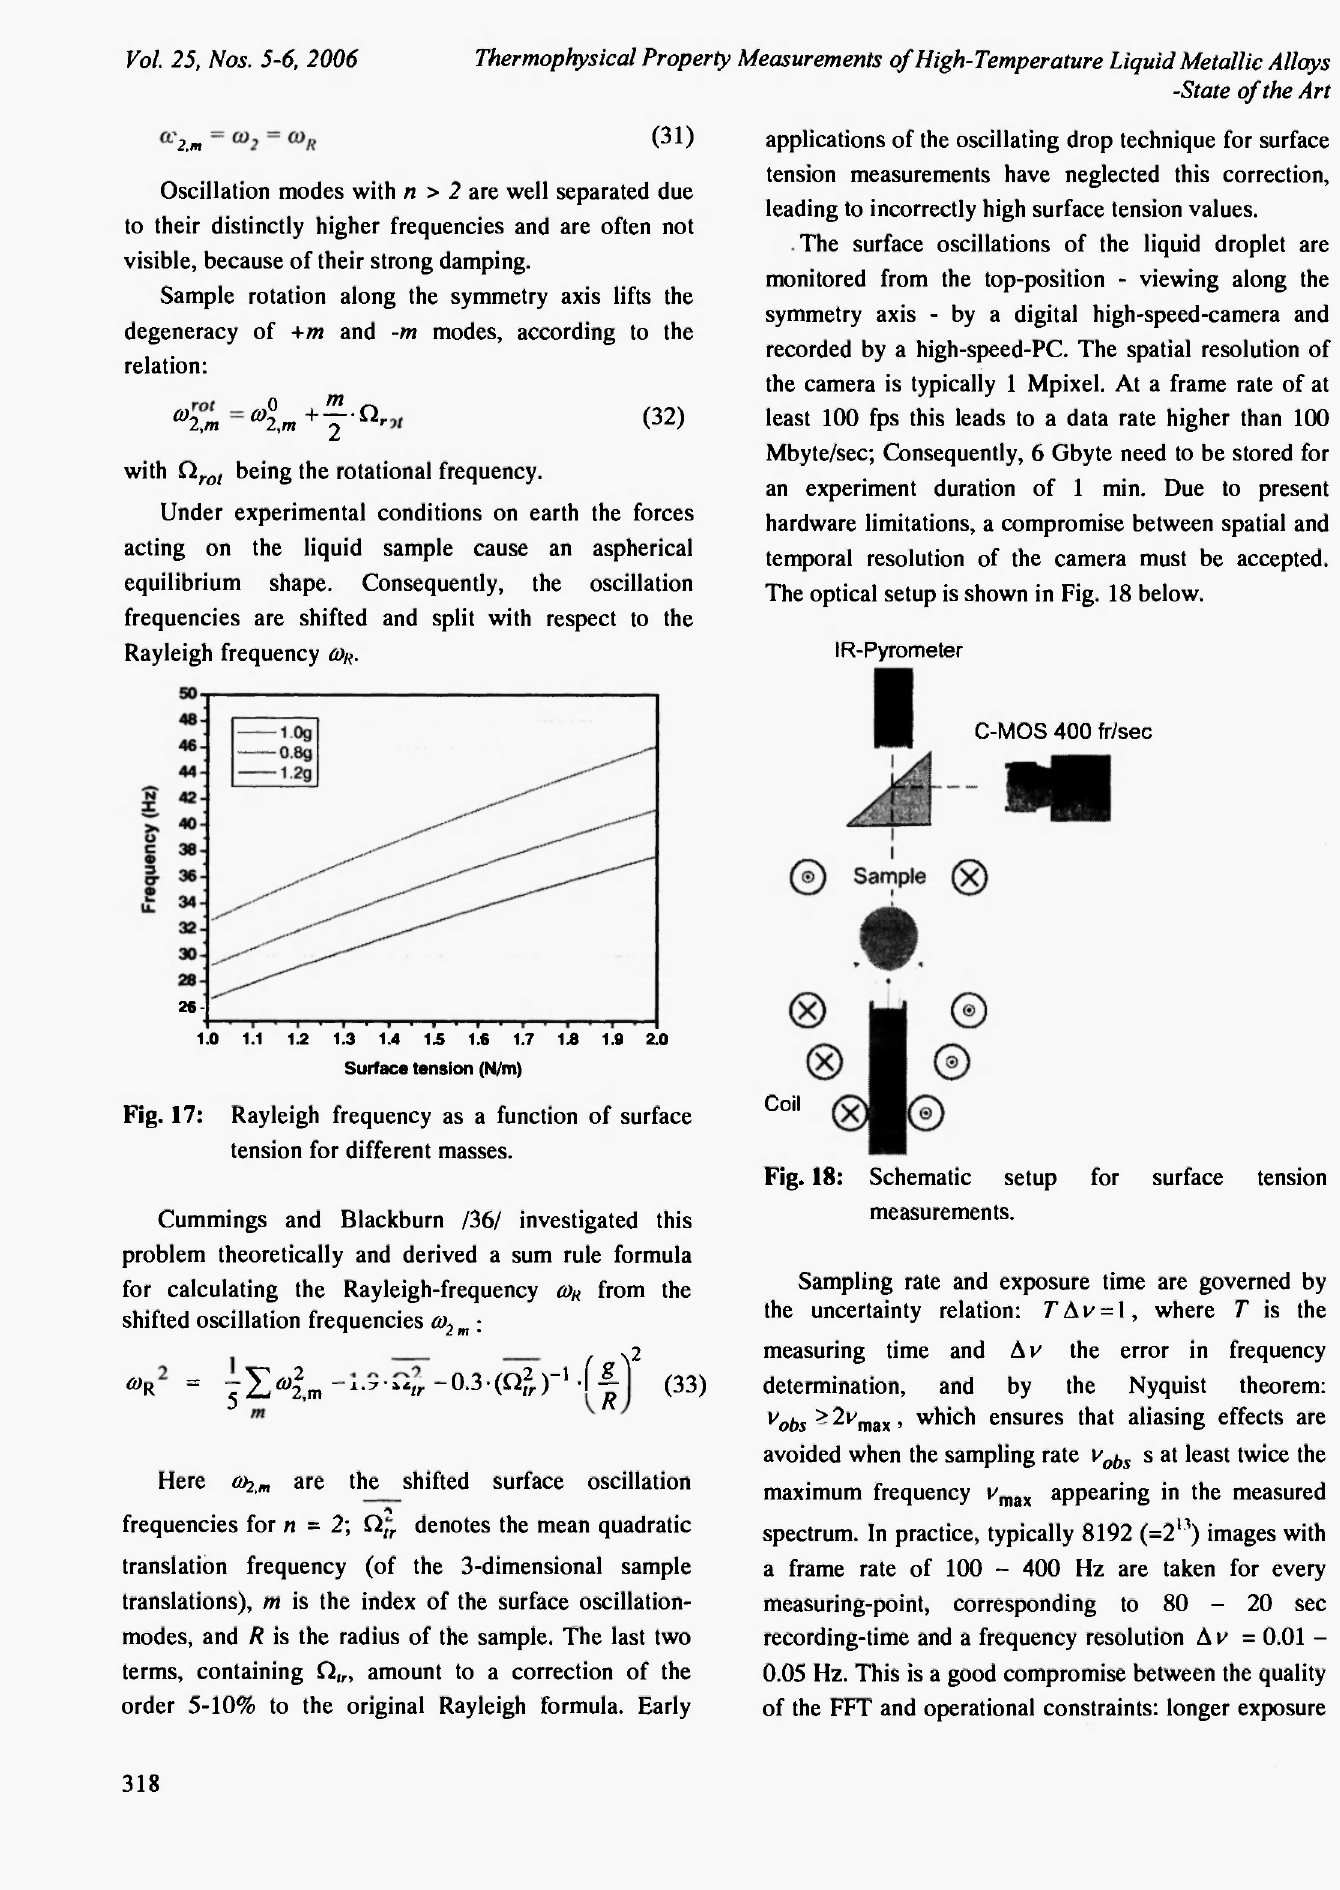
recording-time and a frequency resolution Δ ν = 0.01 - of the FFT and operational constraints: longer